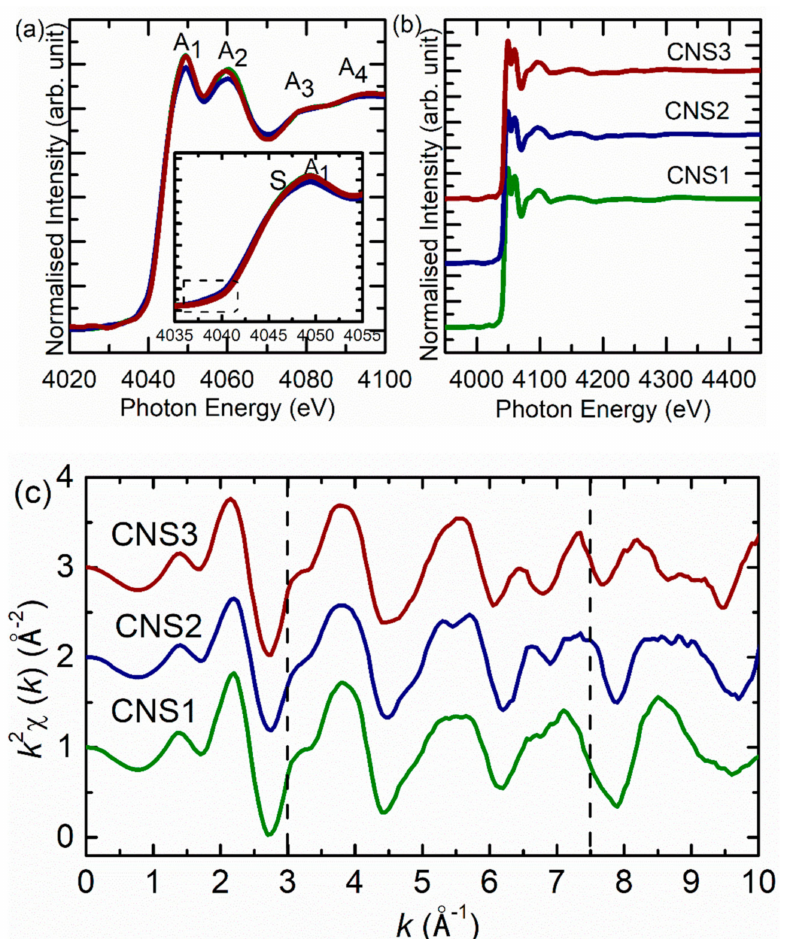
Figure 6. ( a ) XANES and ( b ) EXAFS and ( c ) k -weight EXAFS spectra for CNS1, CNS2 and CNS3. Inset Figure 6a shows the